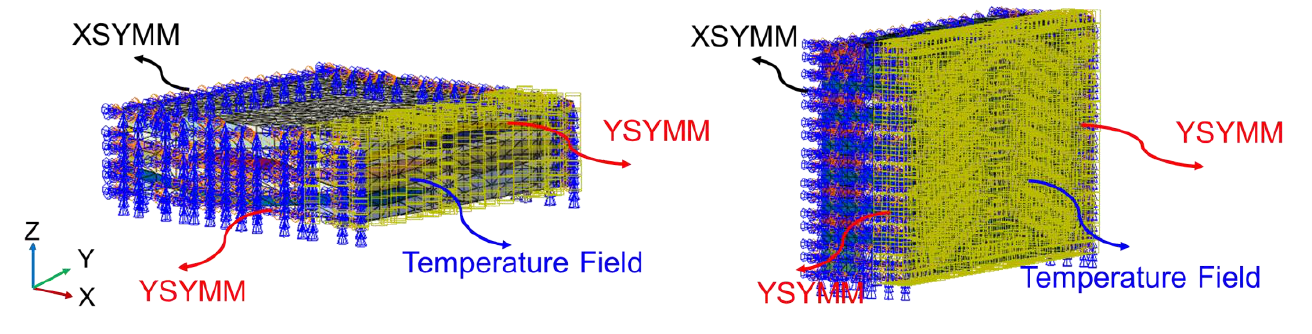
Figure 5. Boundary conditions for 2-D PWC and 2.5-D